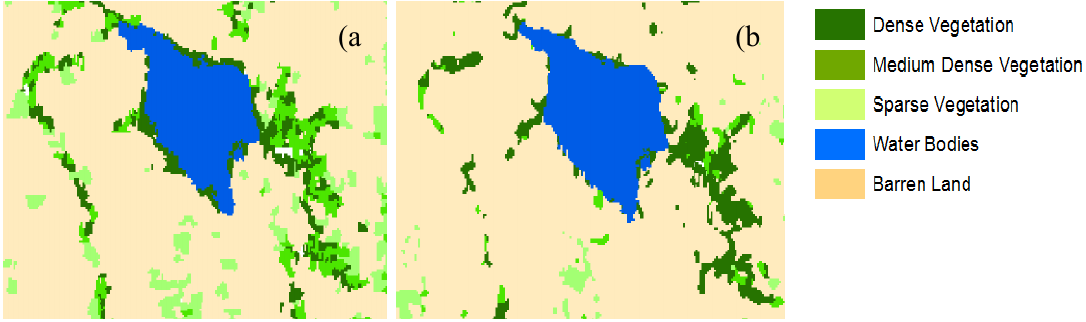
Figure 10. Classification results zoomed near a body of water. In Set 1 ( a ) with MDI, more patches of sparse vegetation exist compared to Set 2 ( b ) without MDI that classified the patches as barren land.